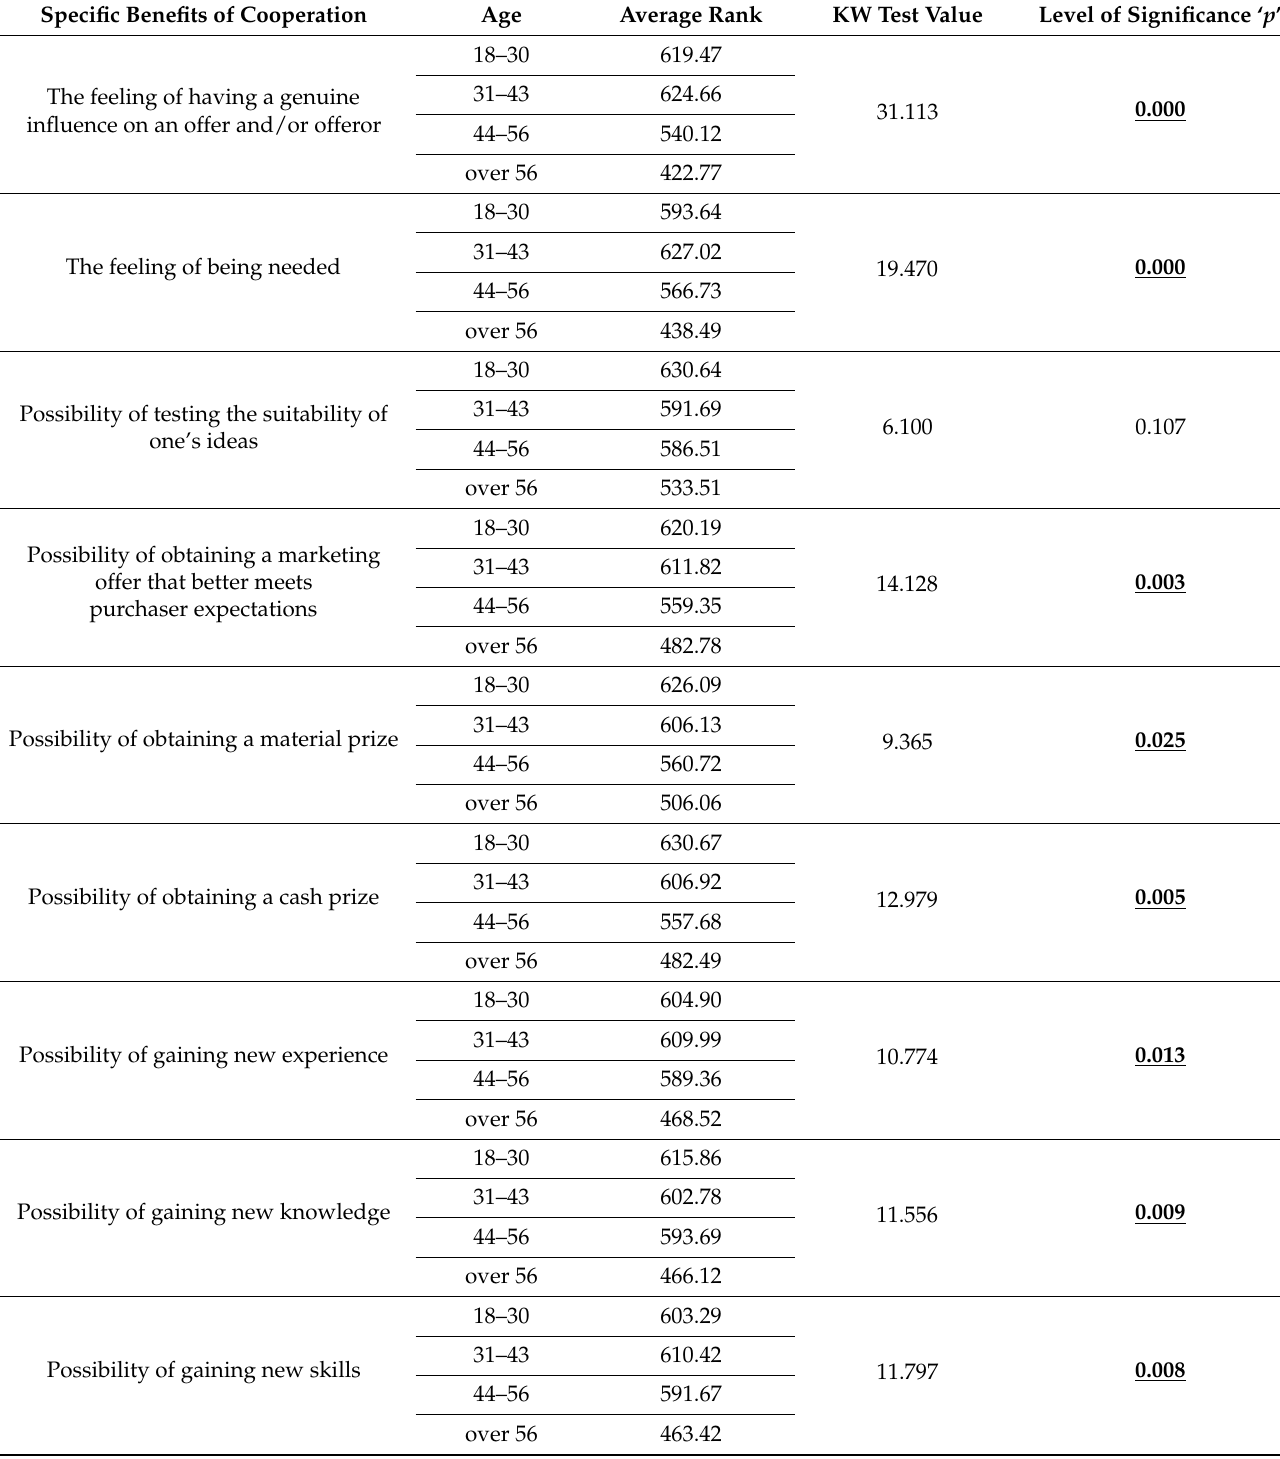
Table 8. Results of the analysis of the significance of differences between respondents’ indications concerning specific benefits achieved by a final purchaser thanks to cooperation with offerors, according to the age of